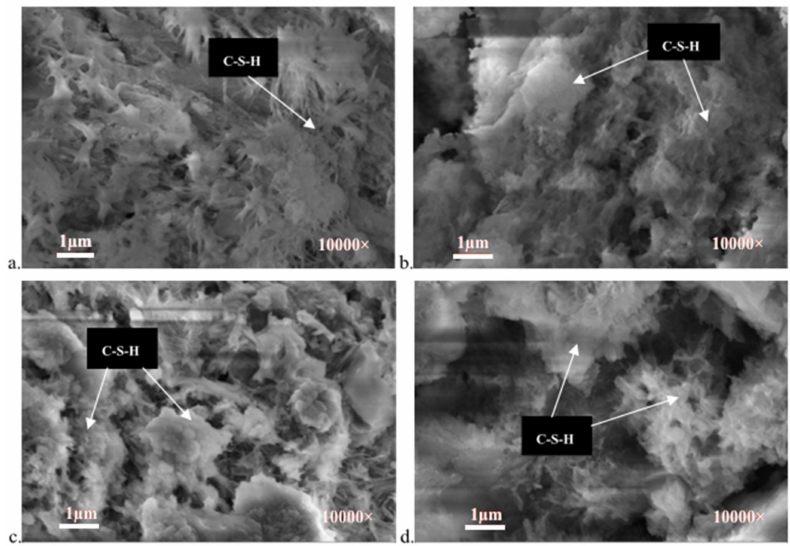
Figure 6. Microstructure of cement composite after acid solution corrosion: ( a ) No nanokaolinite clay (NKC) addition; ( b ) 1% NKC addition; ( c ) 3% NKC addition; ( d ) 5% NKC addition. Adapted from [67], with permission from Elsevier,